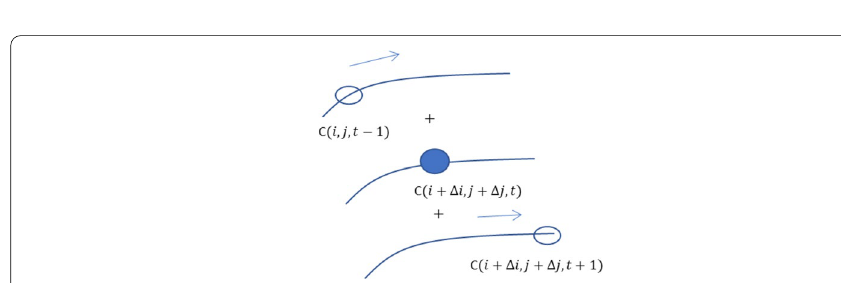
Fig. 6 Shifting and adding